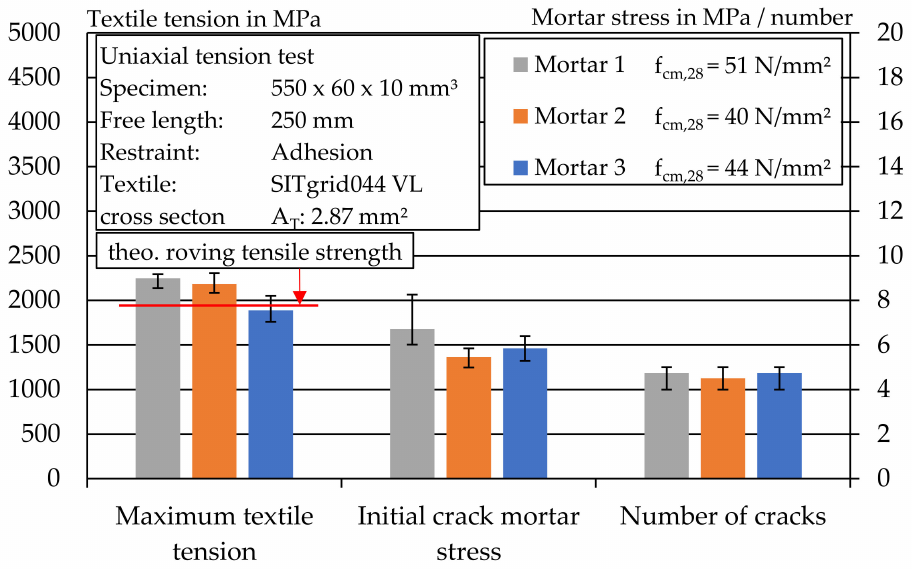
Figure 19. Overview of textile stress, initial crack mortar stress and crack number during a uniaxial tensile test of carbon textile-reinforced